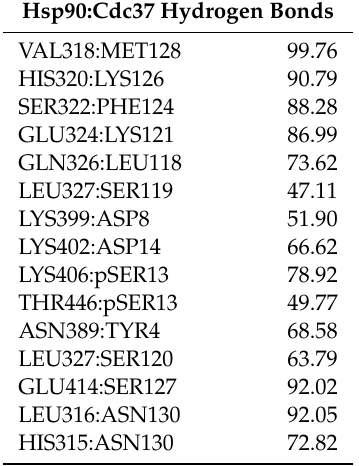
Table 1. Percentage of the existence of the hydrogen bonds occurring between Hsp90 and Cdc37 along the MD simulation of the Hsp90 / Cdk4 / Cdc37